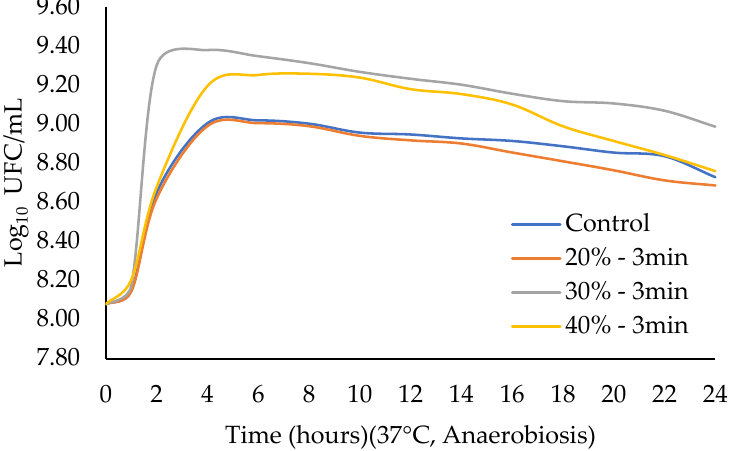
Figure 5. Effect of ultrasound amplitude on the growth curve of Lactobacillus acidophilus .